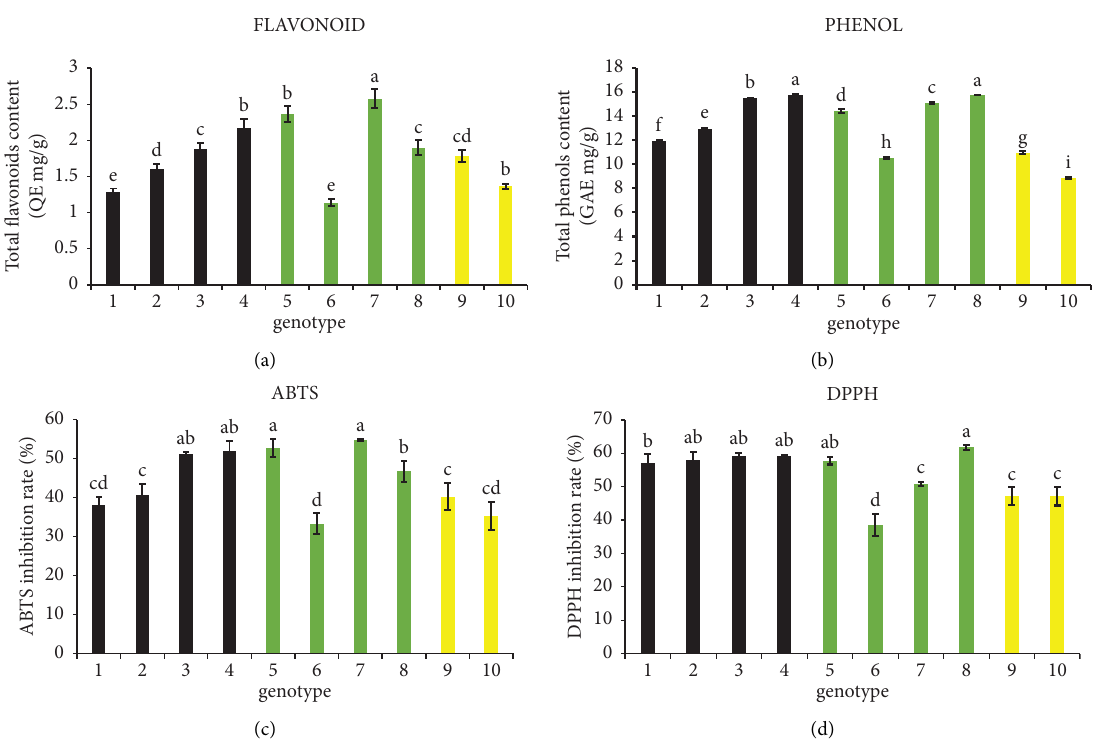
Figure 3: Te content of biochemical compounds and antioxidant activity in the seed coats of mungbeans. (a) Total favonoids, (b) total phenols, (c) ABTS radical scavenging activity, and (d) DPPH radical scavenging activity. Te colors of each bar (black, green, and yellow) indicate the seed coat color. Te error bar indicates the standard deviation. Lowercase letters above the bar indicate statistical signifcance ( p < 0 . 05).